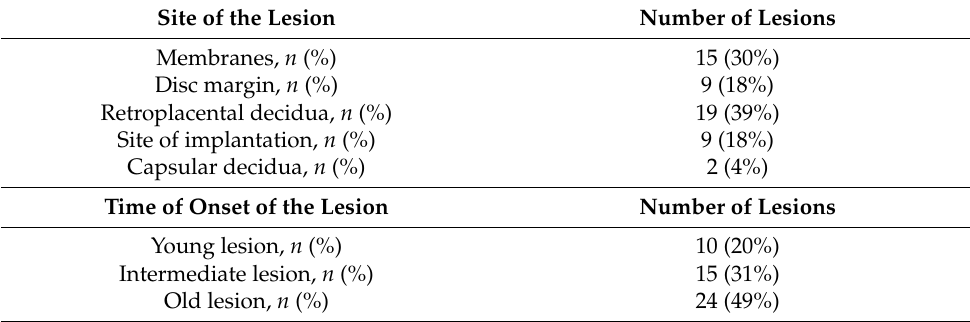
Table 4. Site and time of onset of the lesion.